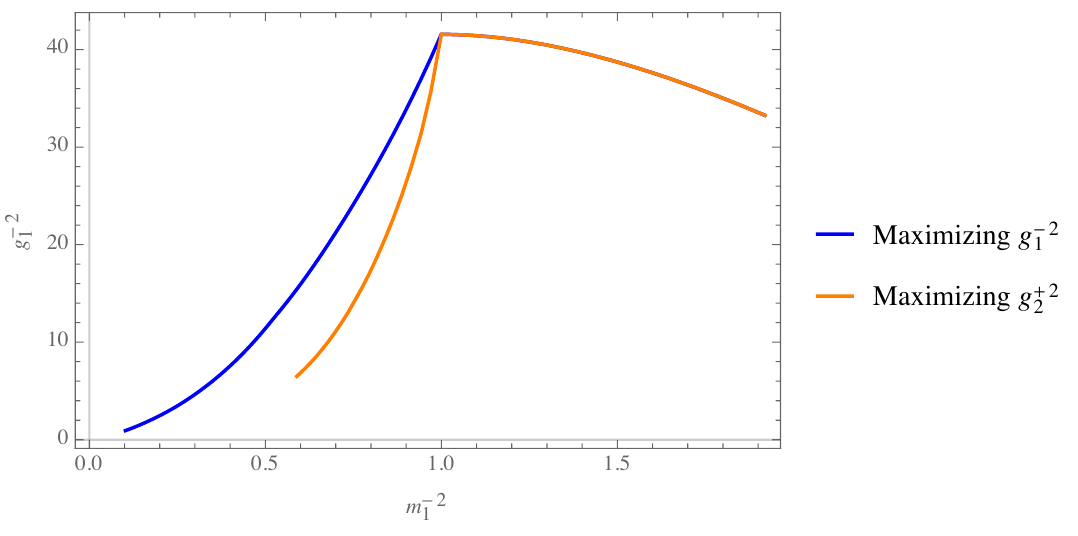
Figure 4 . Comparison of bounds when we maximize the pseudoscalar or scalar couplings. The orange line is the curve for the pseudoscalar coupling when we maximize the scalar coupling. The blue line is the curve for the pseudoscalar coupling when we maximize the pseudoscalar